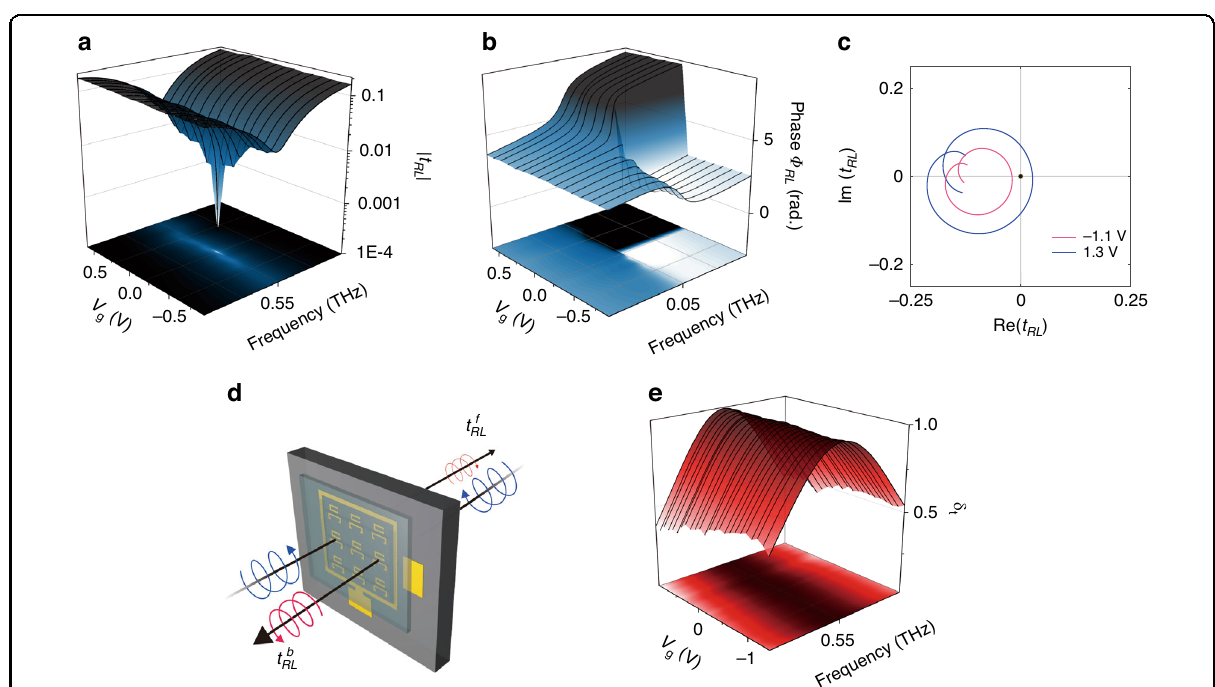
Fig. 5 Gate-controllable cross-polarised transmission tRL and asymmetric polarisation conversion. a - b Transmission amplitude ( a ) and phase ( b ) for t RL in parameter space with incident frequency and gate voltage V g . c Gate-tunable winding number, which indicates the number of times winds around the EP in the complex plane of t RL . d Schematic view for asymmetric polarisation conversion of circularly polarised light through non- Hermitian graphene metasurfaces. e Normalised difference of intensity δ t for the quantitative manifestation of asymmetric polarisation conversion with respect to f and V